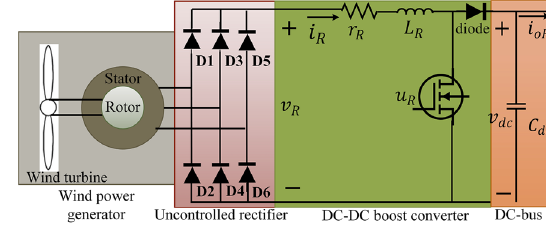
Fig. 4 The equivalent circuit diagram of the PMSG with an uncontrolled rectifier